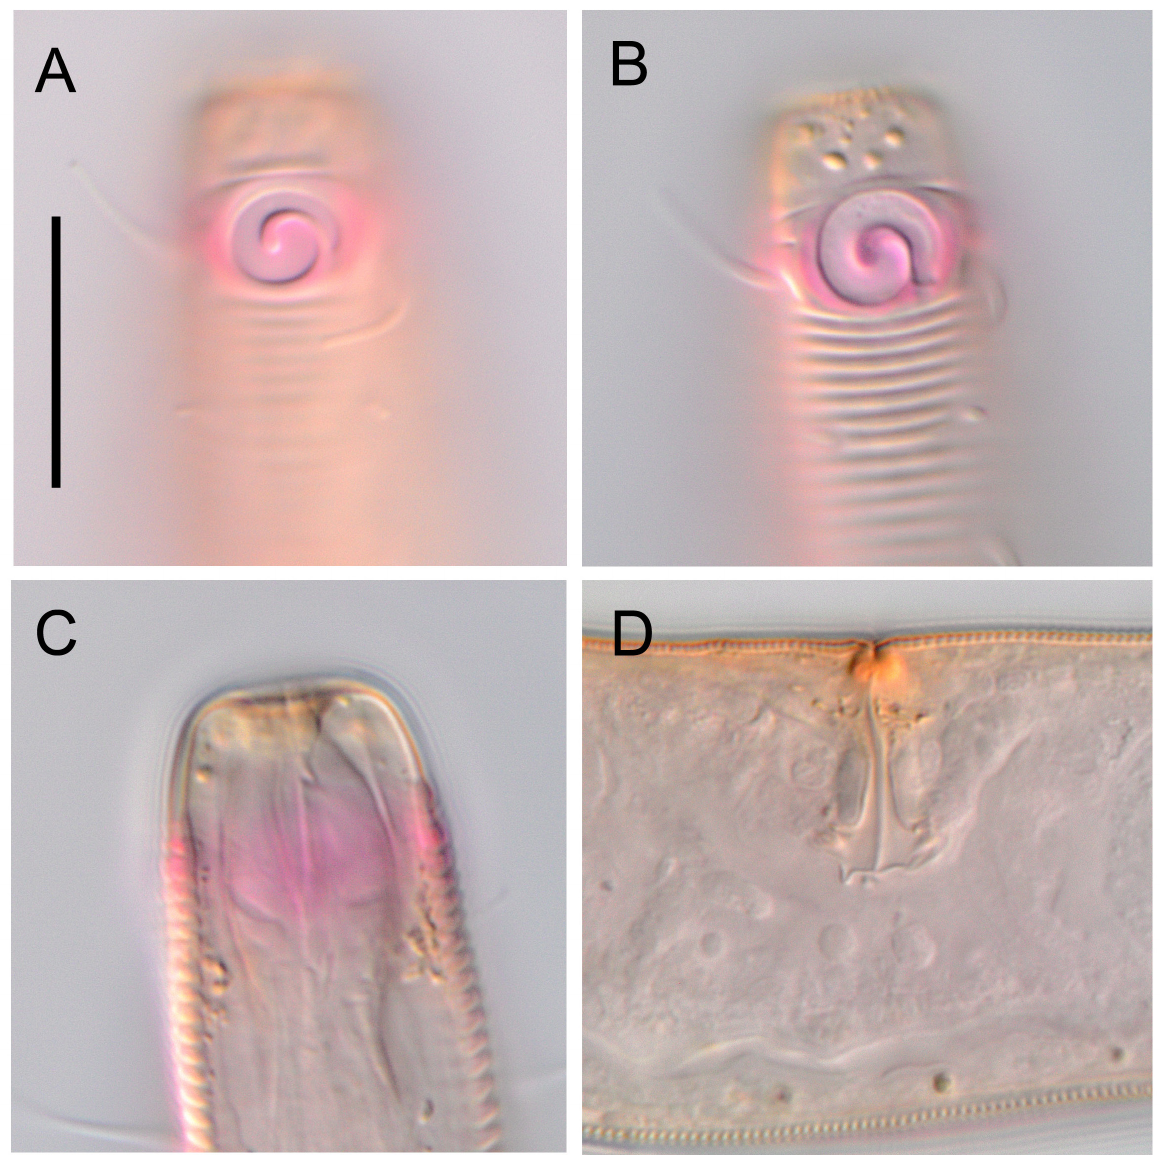
Fig. 6. Stygodesmodora confusa sp. nov., light micrographs of female. A . Head region showing amphideal aperture. B . Head region showing amphideal fovea. C . Head region showing buccal cavity. D . Vulva. Scale bar: A–C = 15 µ m, D = 18 µ